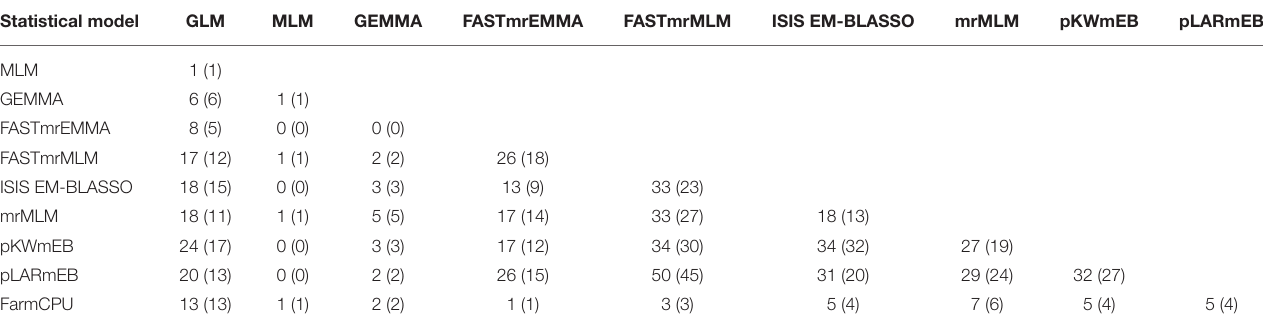
TABLE 5 | Number of common QTNs and QTL identified by any two statistical models.